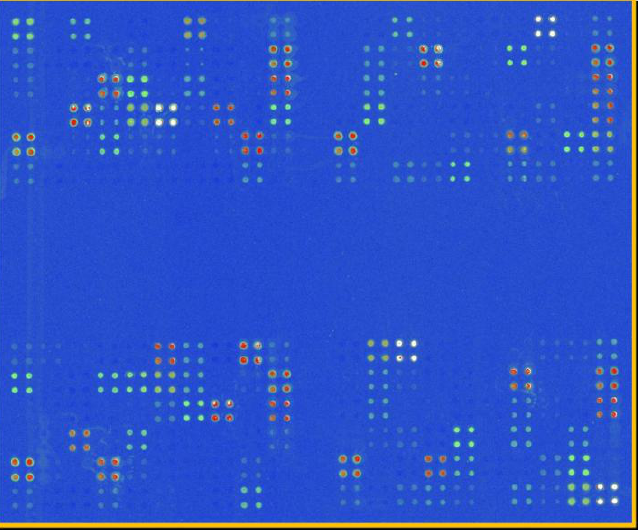
Figure 3. Image of a scanned DNA-microarray from a field sample taken in Galicia, Spain during a toxic algal bloom event. The DNA-chip contained probes for various toxic phytoplankton taxa. Photo taken by Dr. J. Chen in the EU MIDTAL project. Each cluster of four spots represents four replicates of a probe for a toxic species, at the specie level or above. The higher signal (red) indicates that more RNA was bound to that probe during the hybridization steps and therefore more cells of that species were present in the initial